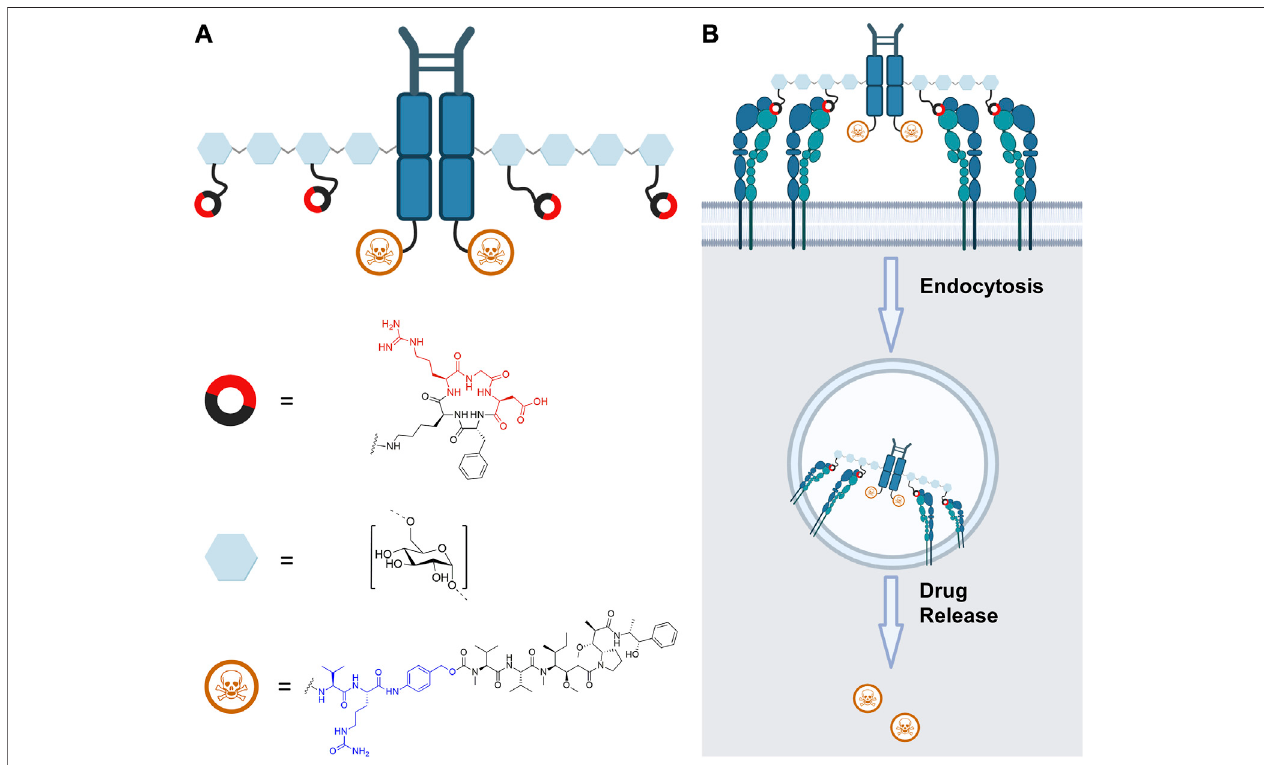
FIGURE 1 | (A) Schematic depiction of human Fc functionalized with the cytotoxic agent MMAE (blue: Val-Cit-PAB linker), dextran, and RGD (red: relevant amino acidsfor receptor binding) with their respective structure. (B) Intended pathway of the RGD-decorated construct, whereby simultaneous binding of multiple integrins on the cellular surface promotes endocytosis. Cleavage of the self-immolative Val-Cit-PAB linker by endosomal cathepsin B leads to release of free MMAE. The fi gure was created with biorender.com.